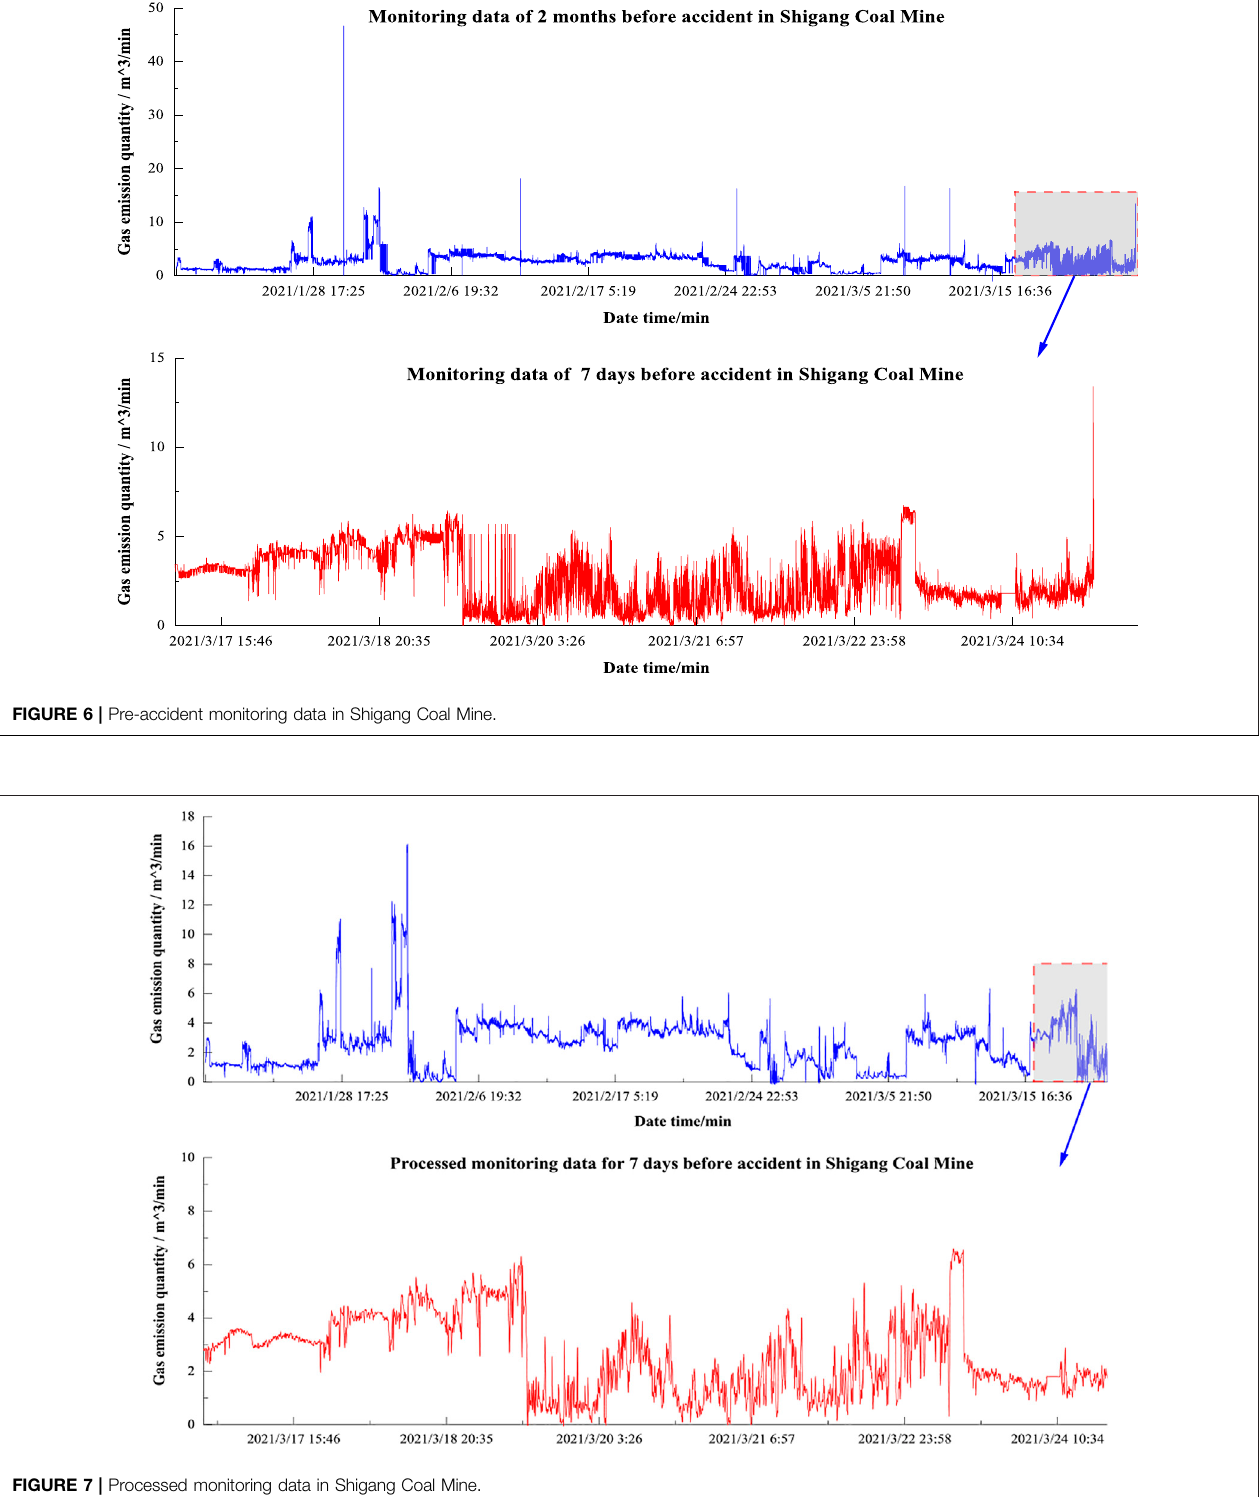
Frontiers in Earth Science |